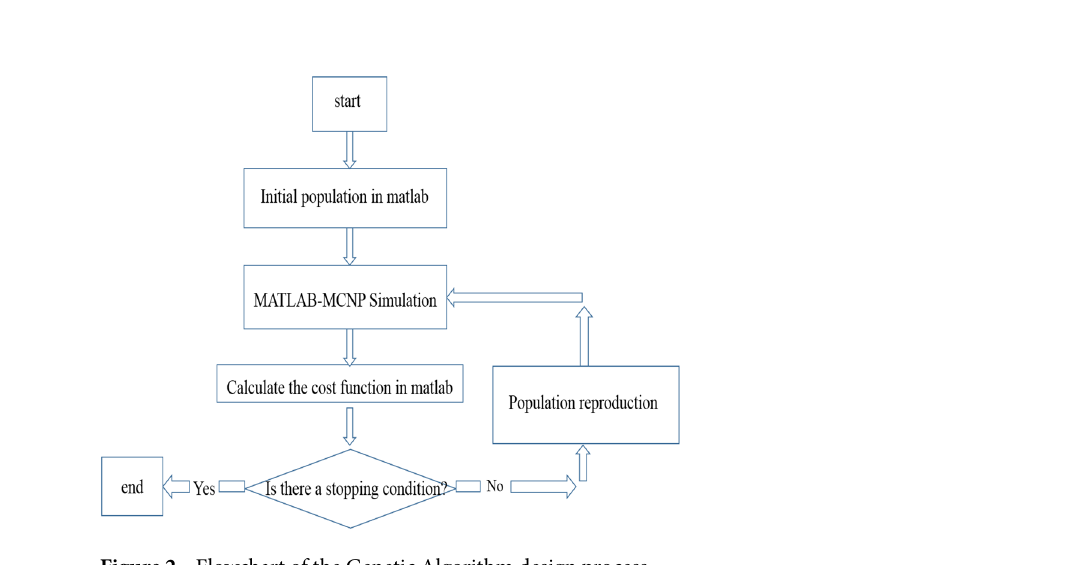
Table 1. Common materials used for designing the radiation shields.